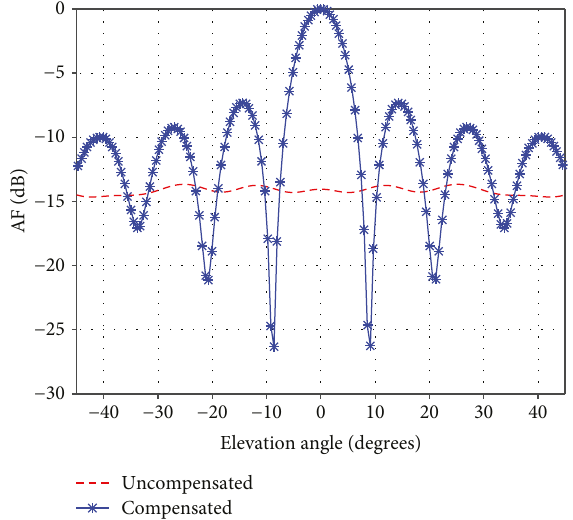
Figure 3: Element positions for the ULA when bent into arcs of di ff erent